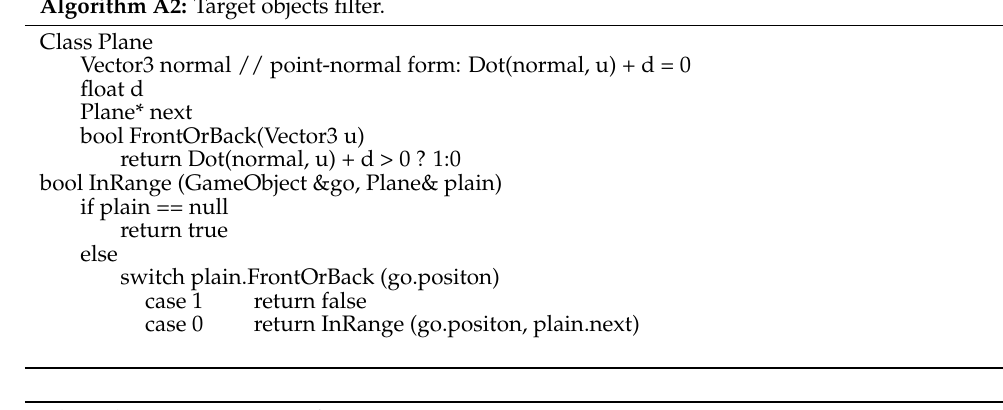
Algorithm A3: Animation